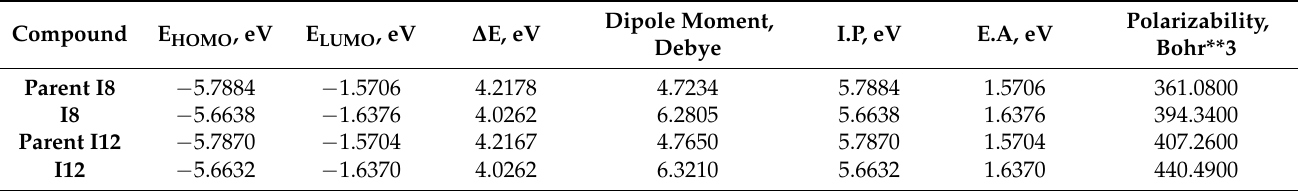
Table 3. Reactivity parameters, dipole moment, and polarizability of compound, In , calculated at the B3LYP/6-31g (d,p) level.